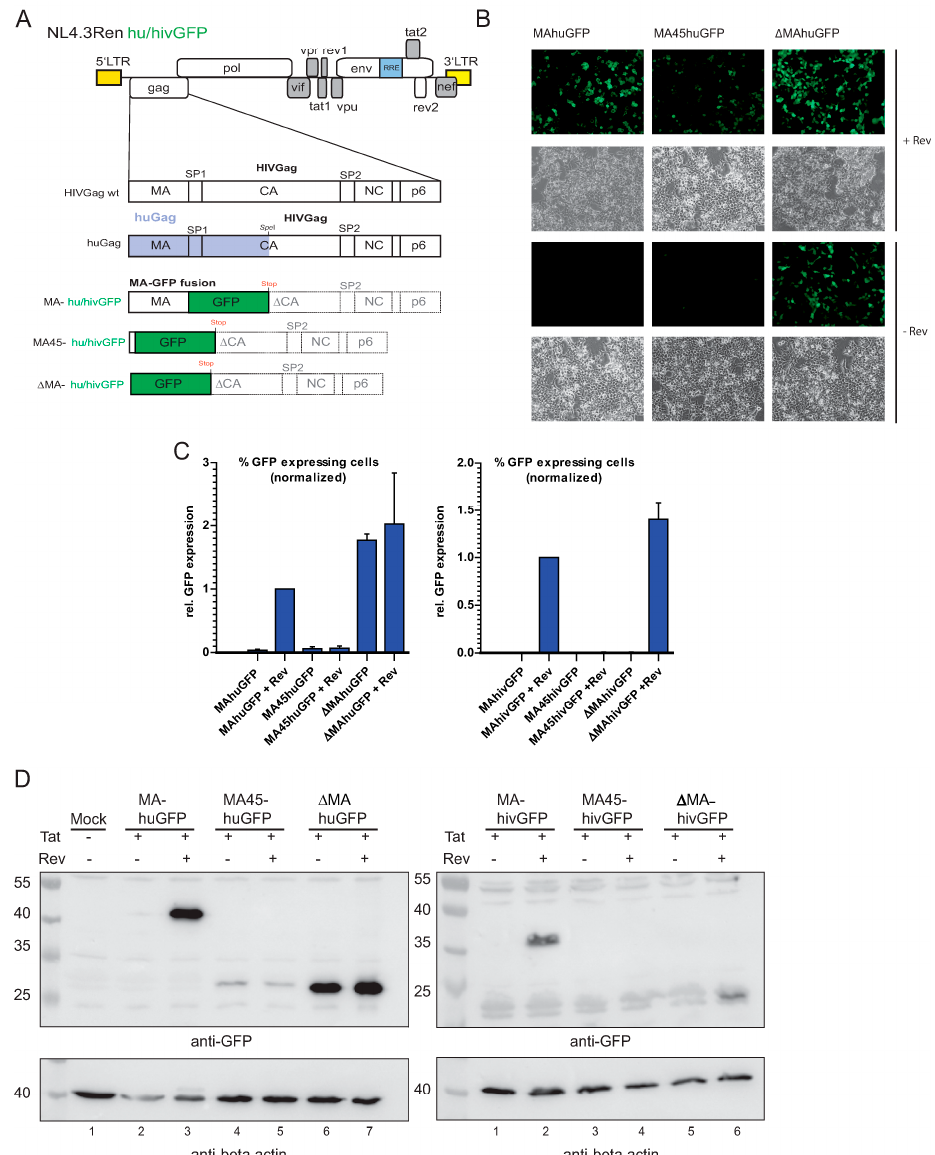
Figure 1. Substitution of the matrix-encoding sequence with huGFP allows Rev-independent expression. ( A ) Depiction of the proviral HIV-1 construct NL4.3Ren (upper part). The LTRs are marked as yellow rectangles. The Rev response element is highlighted in blue. Below a magnification of the gag ORF is shown. Matrix (MA) as well as capsid (CA) and nucleocapsid (NC) are interspaced by the spacer peptides SP1 and 2. At the very C-terminus, the p6 protein is depicted. Next, a chimeric Gag is shown consisting of a sequence optimized part (light violet, up to the SpeI restriction site) and wild type sequences. At the bottom, the three different positions of GFP insertions (humanized (hu) or adapted to HIV nucleotide bias (hiv)) are illustrated: between the matrix and capsid (MAhuGFP/MAhivGFP), after the first 45 nt (i.e., 15 amino acids) of matrix (MA45huGFP/ MA45hivGFP), and at the ATG of matrix ( ∆ MAhuGFP/ ∆ MAhivGFP). The GFP ORF is terminated by a STOP codon followed by a small deletion in CA, leaving the rest of Gag untranslated (light gray dashed rectangles). ( B ) Light and fluorescence microscopy pictures of HEK 293T cells transfected with the different proviral constructs with or without a Rev expression plasmid. ( C ) Flow cytometry analysis of relative GFP expression levels of HEK 293T cells transfected with the indicated constructs. The percentage of GFP expressing cells was normalized to the overall transfection efficiency using β -galactosidase expression as a control for transfection efficiency ( n = 3). Error bars represent SD. Both the huGFP and hivGFP expression levels were separately normalized to the MAhuGFP + Rev or MAhivGFP + Rev control, respectively. ( D ) Western blot using protein extracts from the indicated co-transfections. Detection was performed with an anti-eGFP antibody. Actin served as a loading control. A size marker in kDa is indicated on the